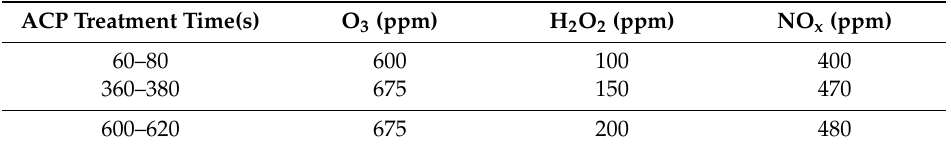
Table 2. Ozone, nitrous oxides and hydrogen peroxide concentration during ACP treatment.